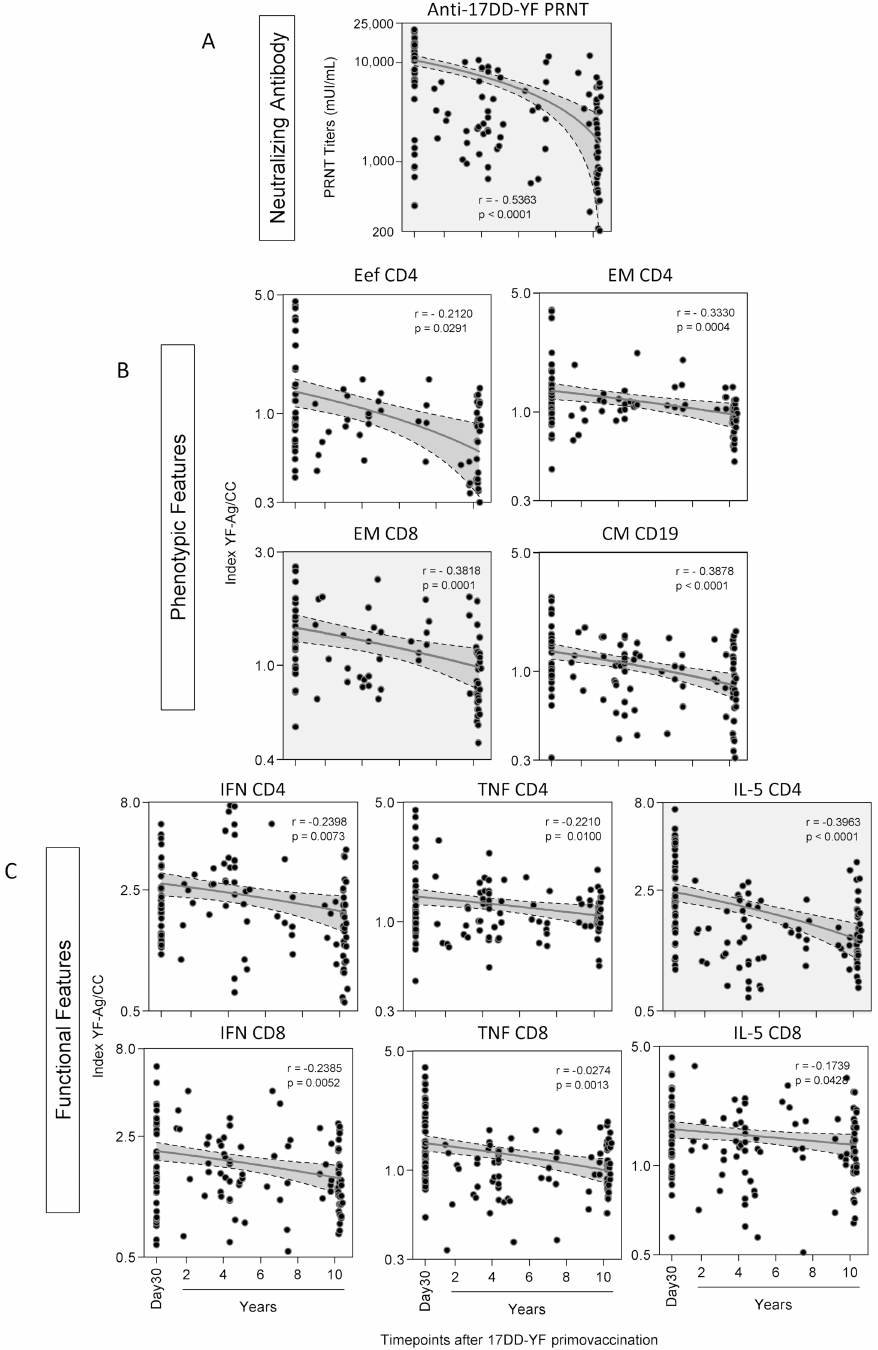
Fig 5. Changes in neutralizing antibody titers and phenotypic/functional memory-related biomarkers at distinct time-points after primary 17DD-YF vaccination. Correlation analyses were performed to validate the time- dependent decline in (A) neutralizing antibody titers and 17DD-YF Memory-related (B) phenotypic and (C) functional features. Data are expressed as scattering distribution of individual values along distinct time-points after 17DD-YF primary vaccination against neutralizing antibody titers (PRNT) as well as phenotypic and functional features (YF-Ag/CC Index). Spearman’s correlation test was applied to identify significant time-dependent loss of memory-related biomarkers. Correlation indices (p and r) along with the 95% confidence band of the best-fit line are provided in the figure. Attributes with higher correlation indices (r values) are highlighted with gray background.